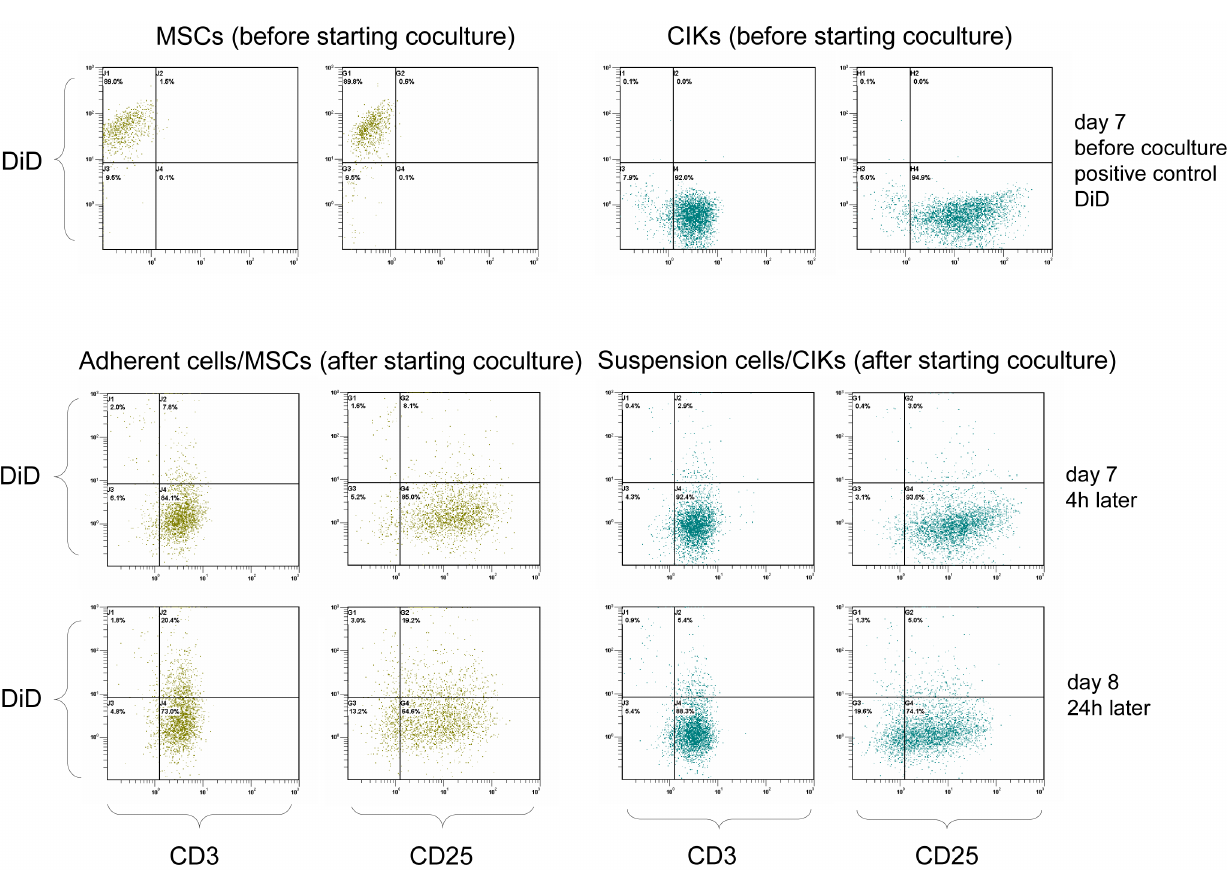
Figure 8. DiD-labelled MSCs. To investigate whether cocultured MSCs were differentiated, we carried out coculture experiments using DiD- labelled MSCs. Suspended cells (cCIKs) and adherent cells were harvested separately from each other after 4 and 24 h of coculture, stained with anti- CD3 and anti-CD25, and analysed using flow cytometry. The first line shows the results of flow cytometry analysis just before the addition of CIKs to the labelled MSCs. Clearly positive DiD signals were seen at the MSCs (positive control). However, CD3 and CD25 were negative, which was expected for MSCs. The CIKs were not labelled and were therefore DiD negative. As for CIKs characteristic, CD3 and CD25 were positive. The second line shows the results of FACS analysis of adherent cells and suspended cells after 4 h of coculture. Adherent cells have switched phenotype from CD3 2 /CD25 2 to CD3 + /CD25 + . DiD signals of adherent cells have disappeared. Suspended cells were still CD3 + /CD25 + and DiD 2 . The third line (after 24 h) confirms the results seen after 4 h. Adherent cells showed the phenotype of the suspended cells and were DiD 2